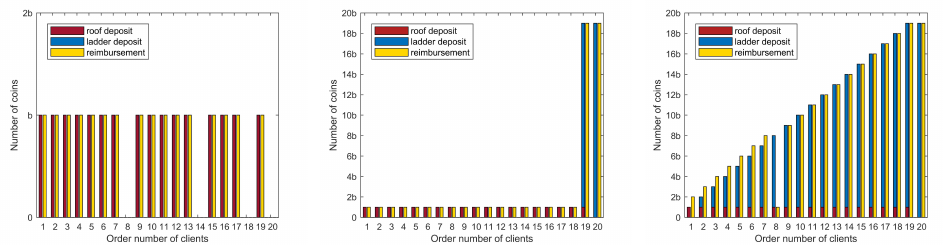
Figure 12. The circulation of digital currencies when there are 20 clients participating in FL and three leave